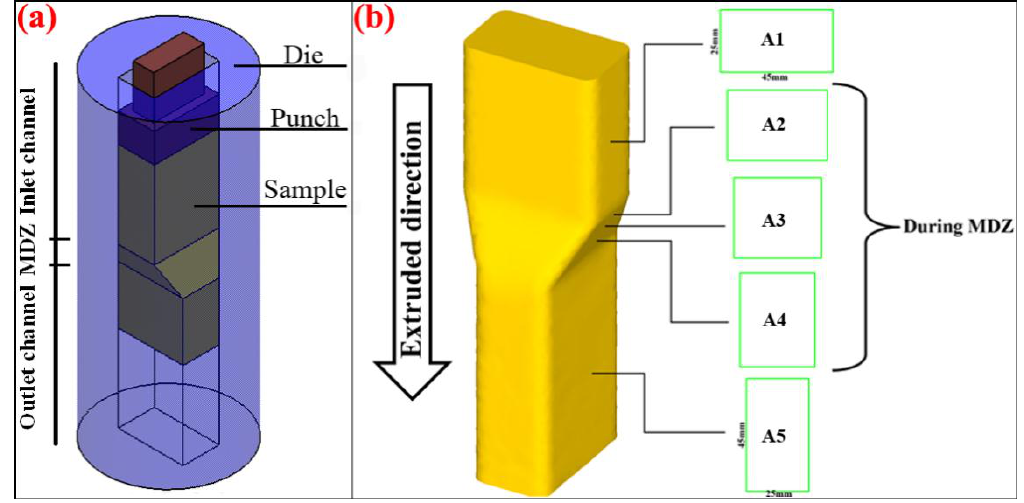
Figure 1. ( a ) The schematic representation of equal channel forward extrusion process and ( b ) the length to width alteration at the billet’s cross-section in the MDZ section during the ECFE process where A1 = A2 = A3 = A4 =